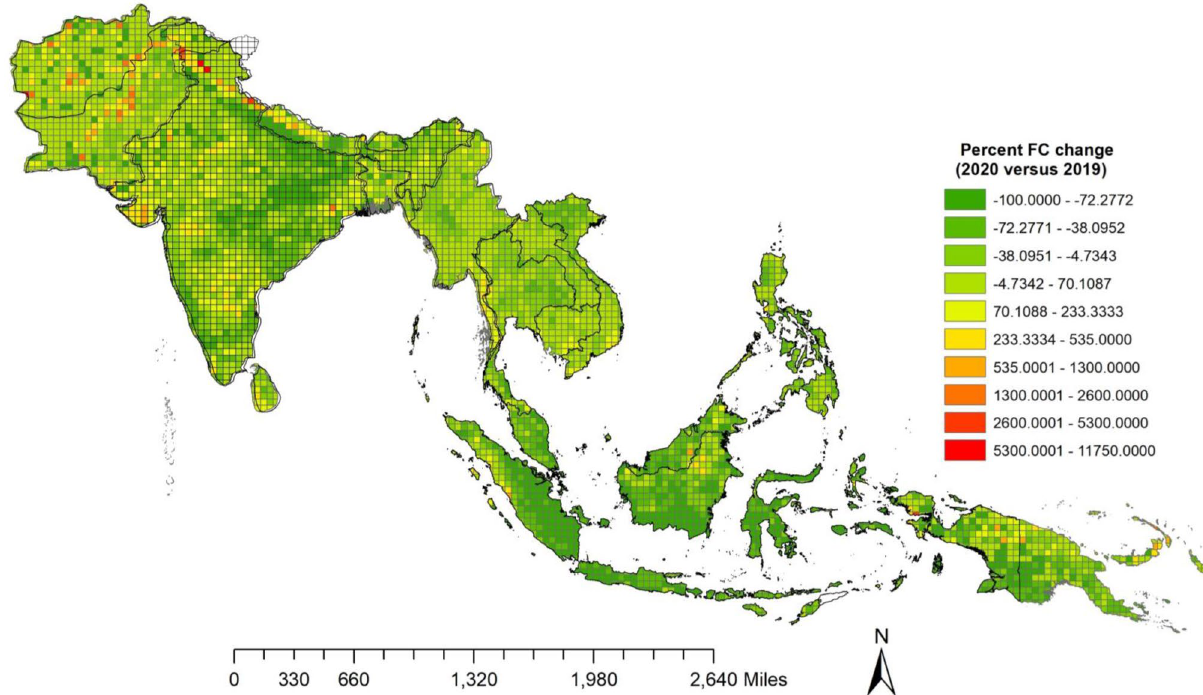
Figure 4. Percent FC change during 2020 versus 2019 for South/Southeast Asia. VIIRS I-band (375 m) fire counts were spatially gridded at 30 min intervals (0.5 × 0.5degree cells) for the regional scale analysis. A clear percent increase in fires can be seen in northern Himalayan region, southern Vietnam, Western Indonesia including northern Kalimantan and Papau New Guinea (Map created using QGIS ver.3.22)